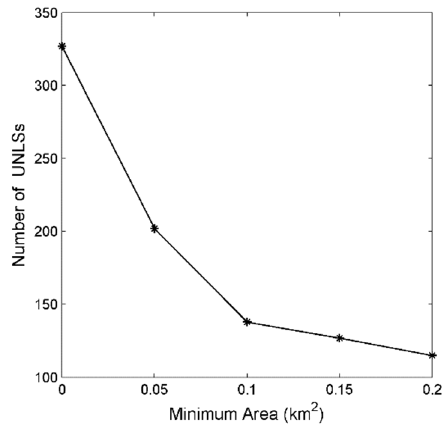
Figure 11. Sensitivity of the detected UNLS to the minimum area parameter.